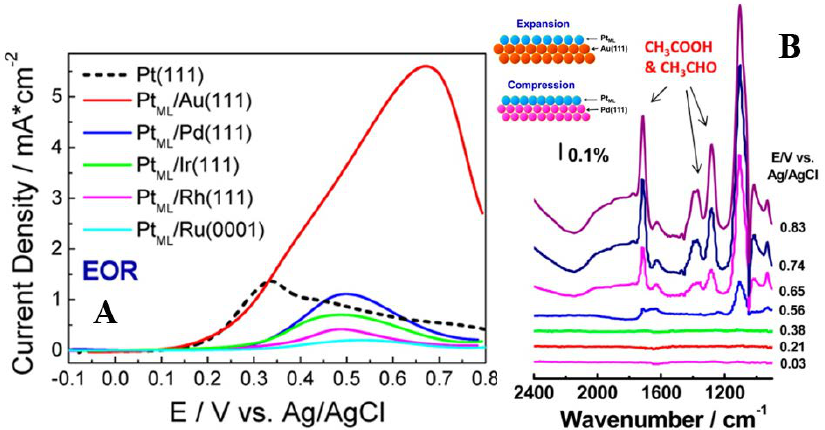
Figure 8. ( A ) Positive voltammetric scans for Pt(111) and Pt ML supported on five different substrates infrared reflection-absorption spectroscopy (IRRAS) spectra recorded during EOR on the Pt ML /Au(111) electrode in 0.1 M HClO 4 containing 0.5 M ethanol. Inserted are models of pseudomorphic monolayers of Pt on two different substrates of Au(111) and Pd(111). Reprinted and adapted with permission from Reference [105]. Copyright 2012, American Chemical